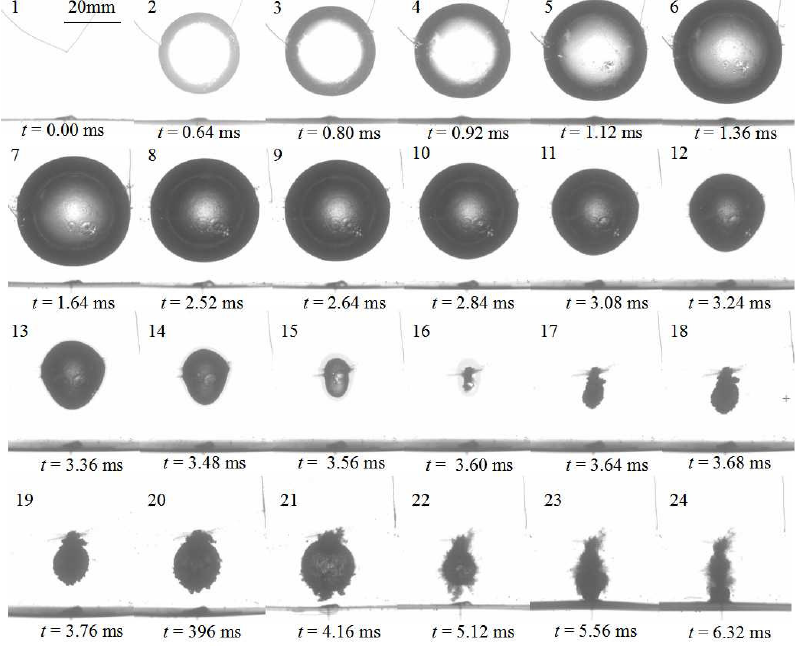
Figure 8. The comparison of the temporal evolution of two bubble margins and mid-span displacement of elastic boundaries for γ = 1.20 and R m = 20.0 mm.